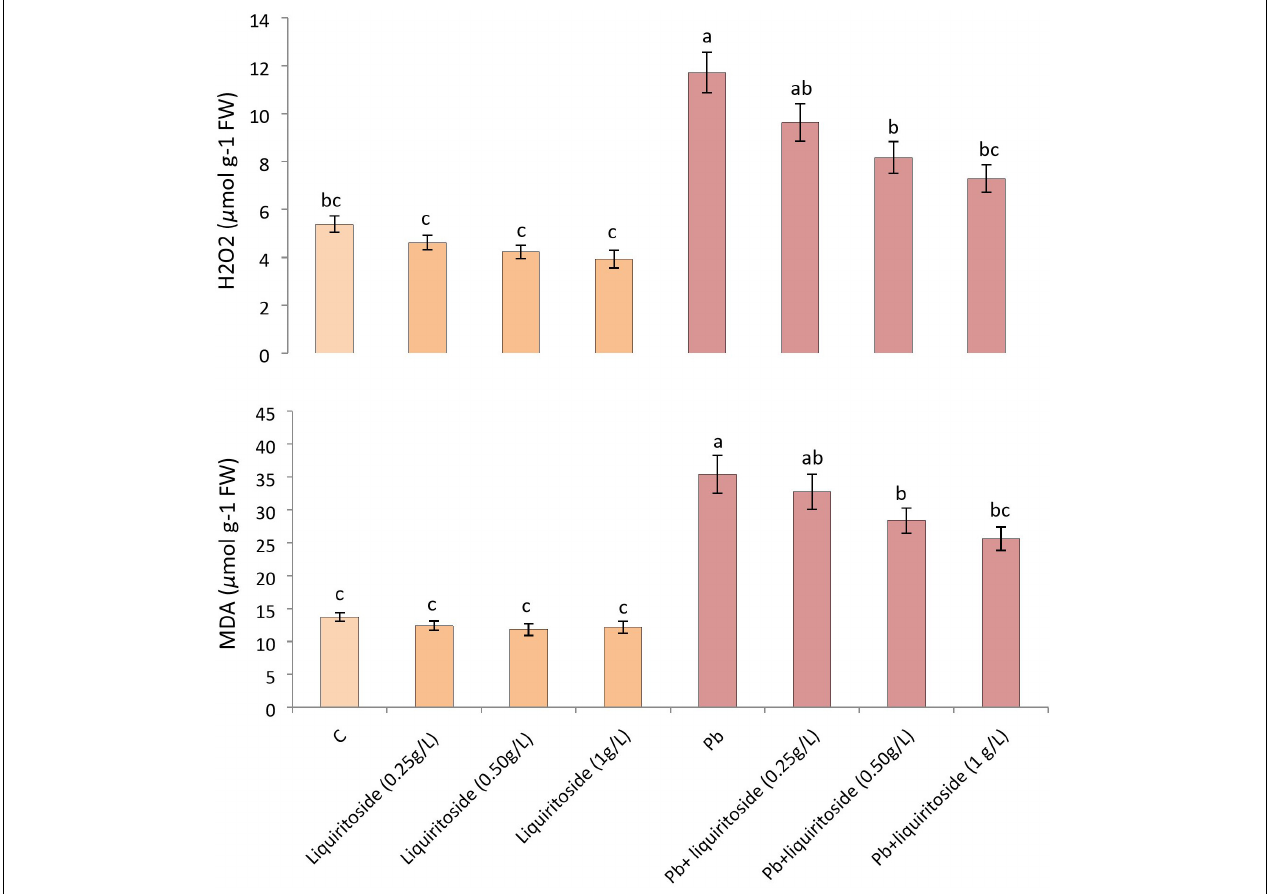
FIGURE 3 | Effect of liquiritoside on the amounts of malondialdehyde (MDA) and hydrogen peroxide (H 2 O 2 ) in Chinese flowering cabbage plants under lead stress. Mean values of two independent experiments are presented. Vertical bars show standard error between different replicates of the same treatment. Data marked by the different letters in the same column are significantly different at p < 0.05. Pb, lead; C, Control. TABLE 5 | Role of liquiritoside on Pb uptake in root and shoot tissues, bio-concentration factor (BCF), translocation factor (TF) and tolerance index (TI) of Chinese flowering cabbage plants under lead (Pb) stress. Treatments